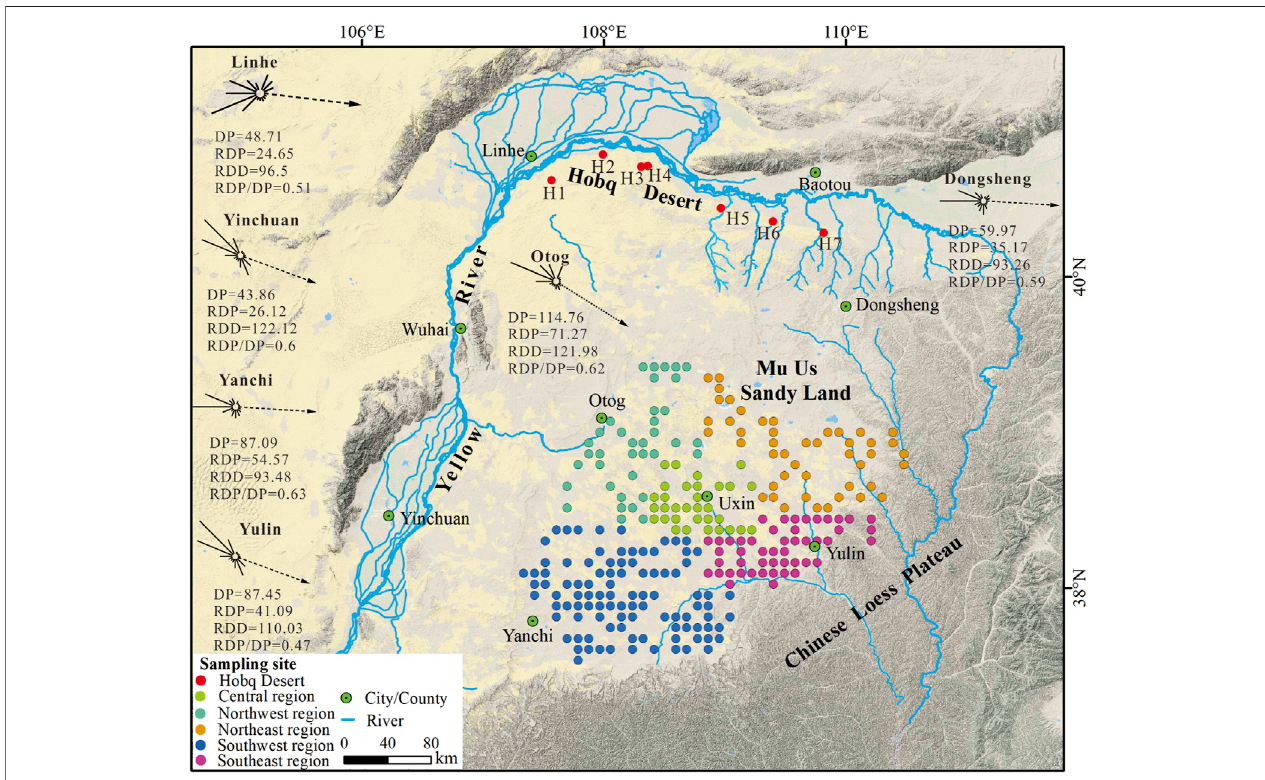
FIGURE 2 | Locations of sand dune samples in the Ordos Deserts. Sand transport roses are calculated based on the descriptions of the wind environment proposed by (Fryberger, 1979) with data from the U.S. National Climate Data Center (NCDC). Abbreviations: DP, drift potential; RDP, resultant drift potential; RDD, resultant drift direction; RDP/DP, directional